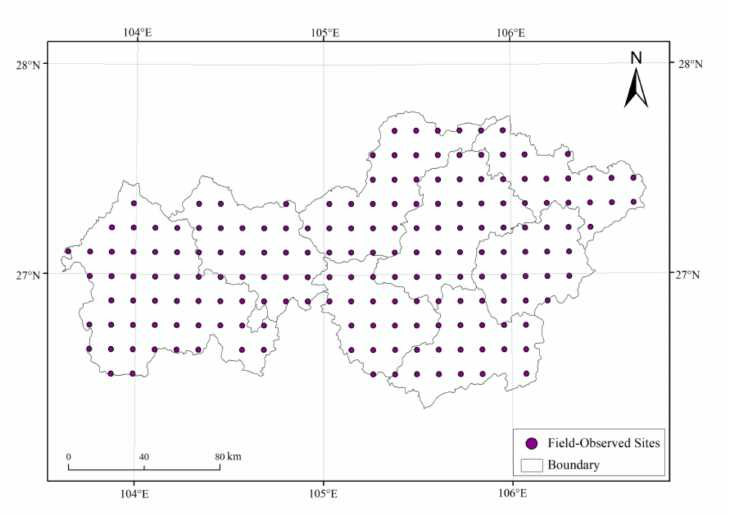
Figure 5. Spatial distribution of the field-observed sites. Table 2. Error matrix of different levels of rocky desertification in